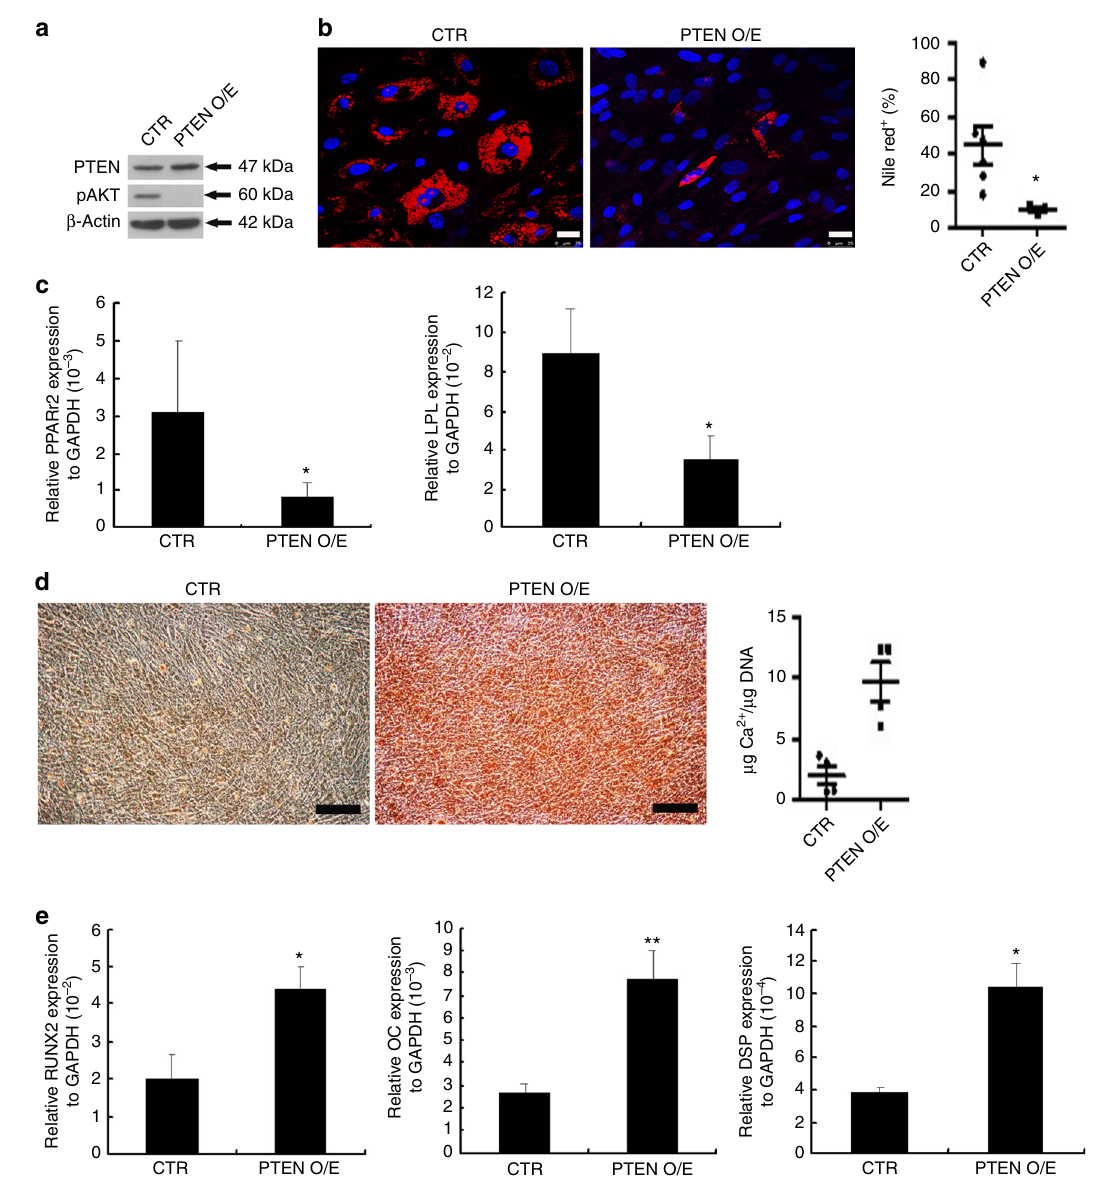
Fig. 4 PTEN overexpression decreases adipogenesis and increases osteogenesis in BM-MSCs. a – e BM-MSCs were transfected with a control plasmid pcDNA6 TM V5-HisA (CTR) or an overexpression plasmid, pcDNA6-PTEN (PTEN O/E), followed by induction for b , c adipogenic or d , e osteogenic differentiation. a Cells were analyzed by western blotting. b Cells induced for adipogenic induction were stained by nile red and (right) quanti fi cation of nile red positive cell percentages. Bar = 25 μ m. c Quantitative RT-PCR for the mRNA levels 7 days after differentiation. d Cells induced for osteogenic differentiation were analyzed by Arsenazo III kit and (right) quanti fi cation of the calcium contents relative to DNA contents at 2 weeks. Bar = 200 μ m. e Quantitative RT-PCR for the mRNA levels 7 days after differentiation. c , e Results are shown as the relative expression to GAPDH (mean ± SD of three independent experiments), and signi fi cance was determined by Student ’ s t -test. (* p < 0.05 and ** p < 0.01 versus